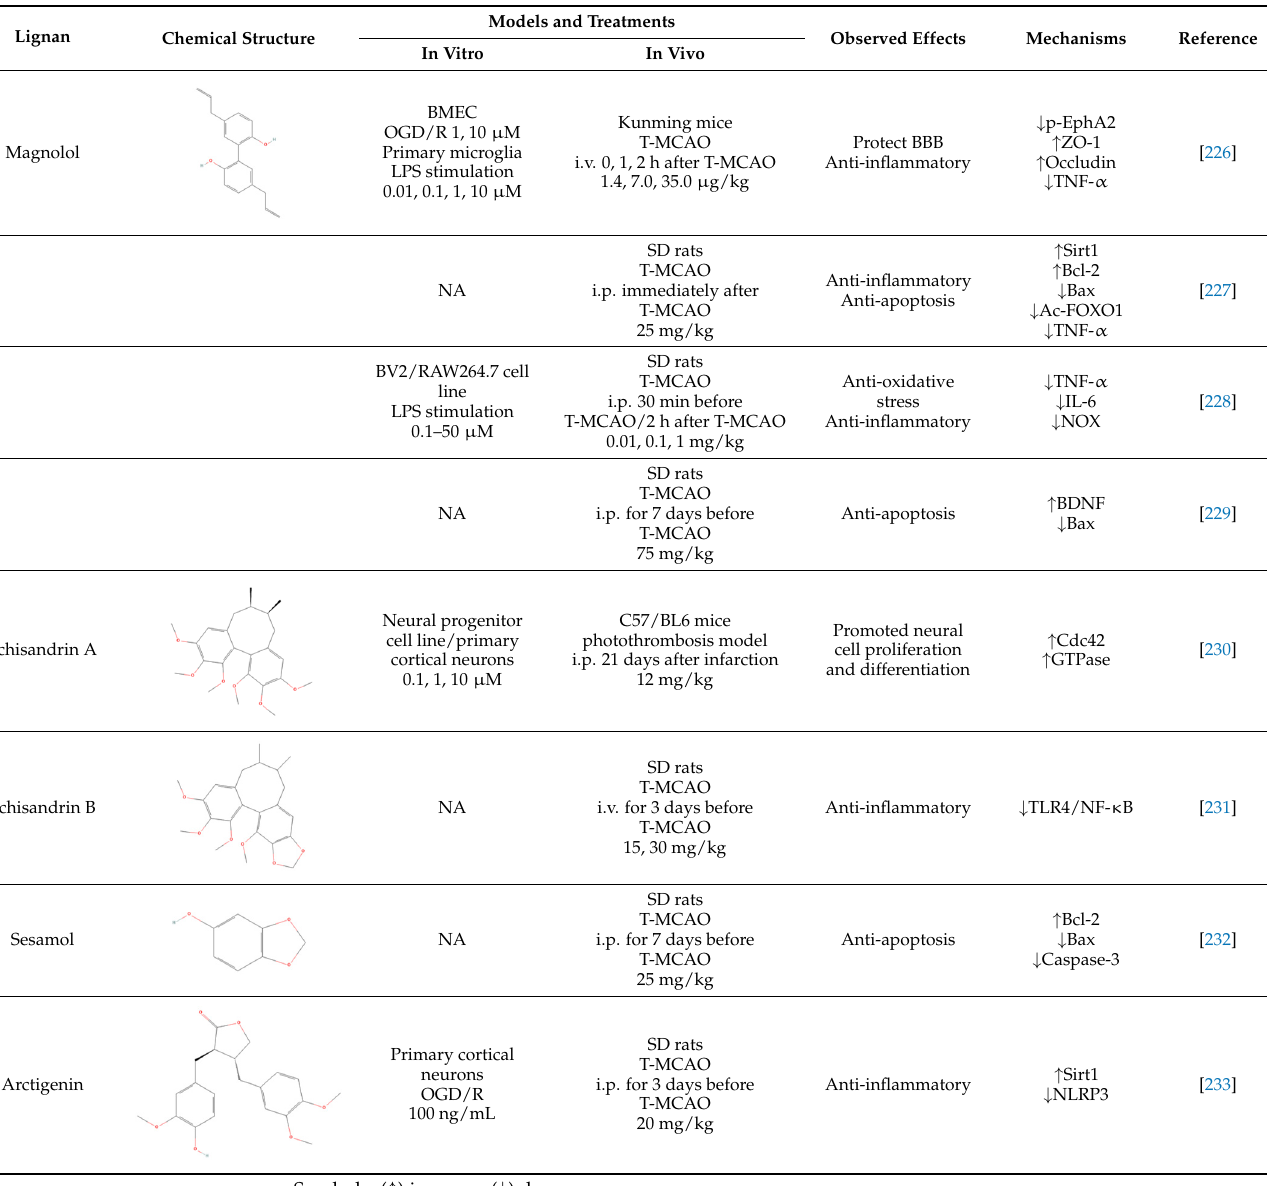
Table 3. Summary of recent studies on anti-IS effects of lignans.